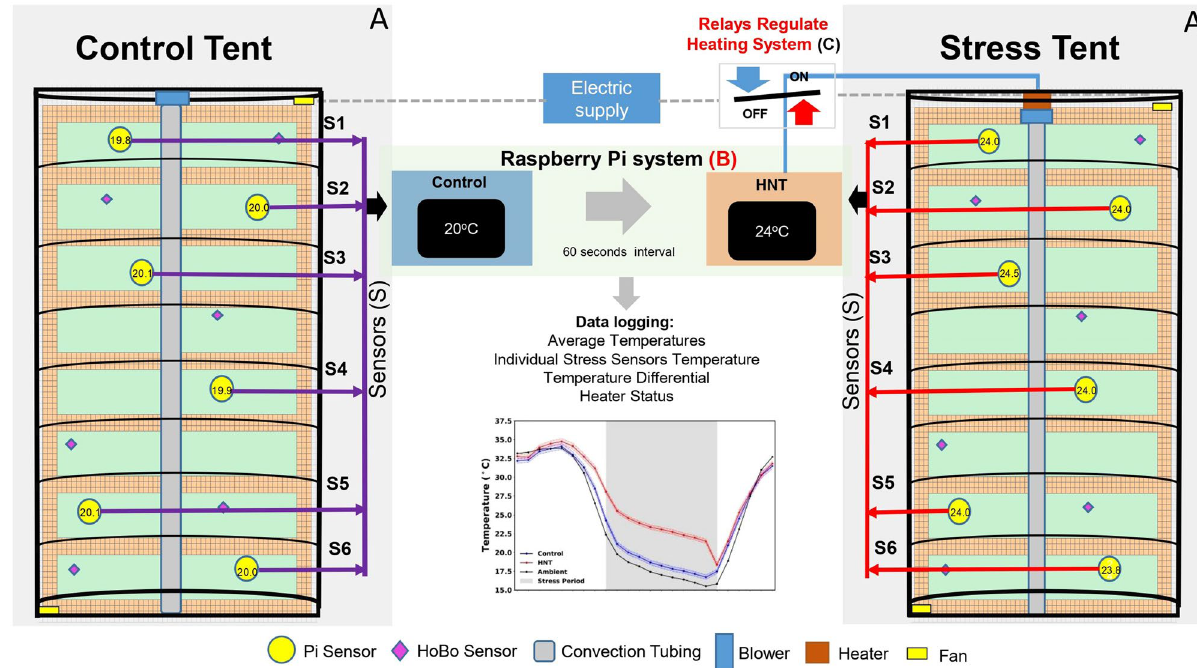
Figure 2. Diagrammatic presentation of a paired control tent with a stress tent, depicting the operation. ( A ) A detailed interior view of the stress and control tent; see Supplementary Fig. 1. ( B ) A detailed explanation of Raspberry Pi System and its wiring is presented in Supplementary Figs. 2–4, Supplementary File System Details and Code and Supplementary Table 2. ( C ) An overview of the relay system and their wiring can be found in Supplementary Figs. 3 and